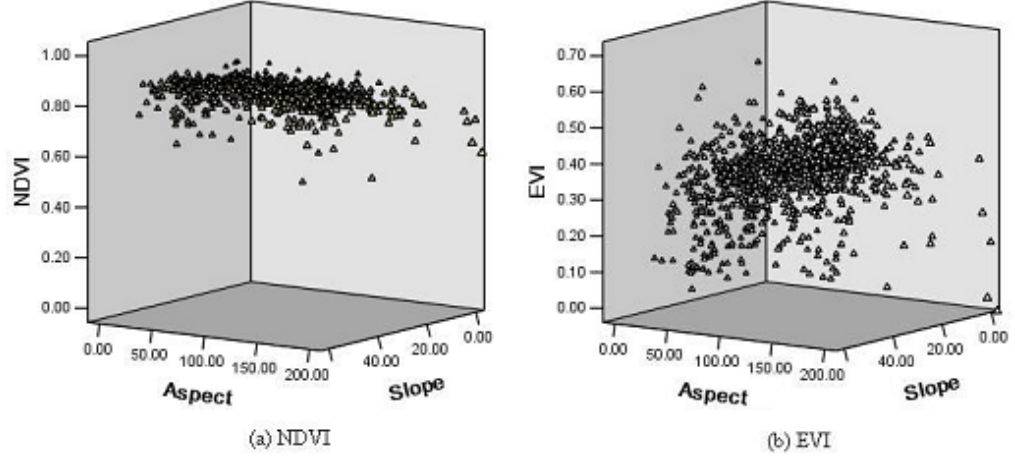
Figure 3. 3-D Scatter plots of NDVI and EVI of randomly selected 1000 samples from the image.